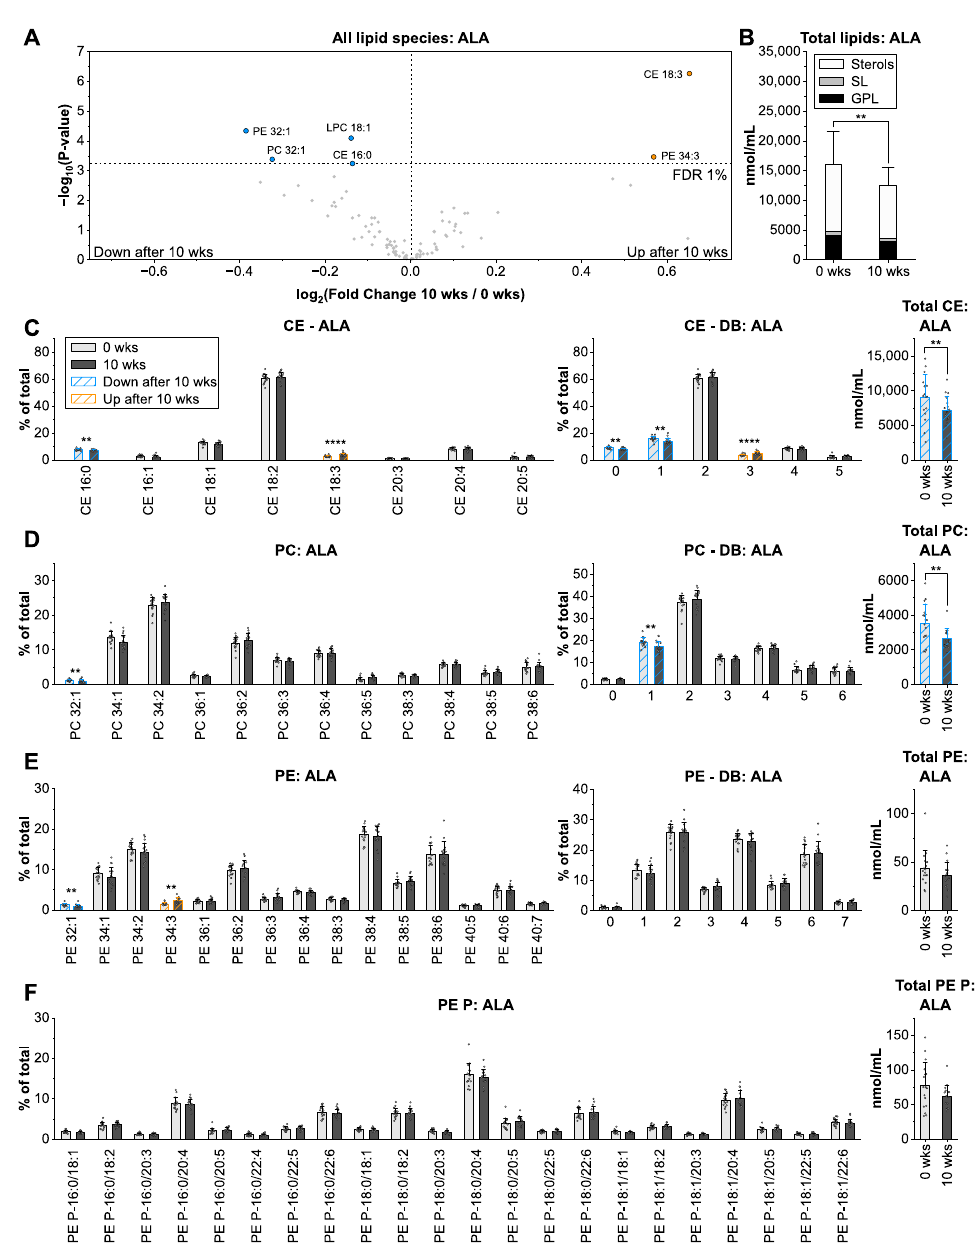
Figure 3. Impact of linseed oil intervention on the human plasma lipidome. The arrangement of panels ( A – F ) is identical to Figure 2. Shown are means ± SD of lipid species with an average contribution > 1% from n = 17. ** p < 0.01, **** p < 0.0001. 3.4. Stearidonic Acid from Echium Oil Enriches in Glycerophospholipids with 4–5 Double Bonds Although the intervention with echium oil (31% ALA and 11% stearidonic acid, SDA; FA 18:4 n -3) did not alter total lipid concentrations, lipid species composition was more drastically affected than observed for sunflower and linseed oils (Figure 4A,B). The proportions of 22 lipid species were significantly altered with fold changes between − 1.2 and +2.5-fold. After 10 wks of intervention, the GPL pattern shifted towards species